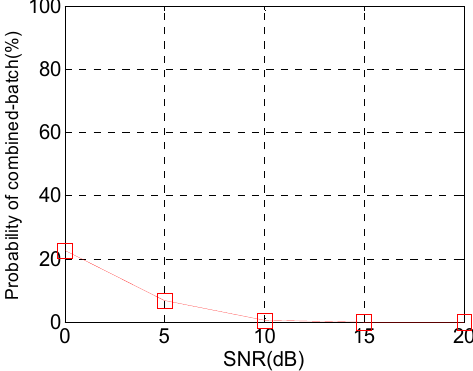
Figure 10. Probability of combining-batch in different SNRs.